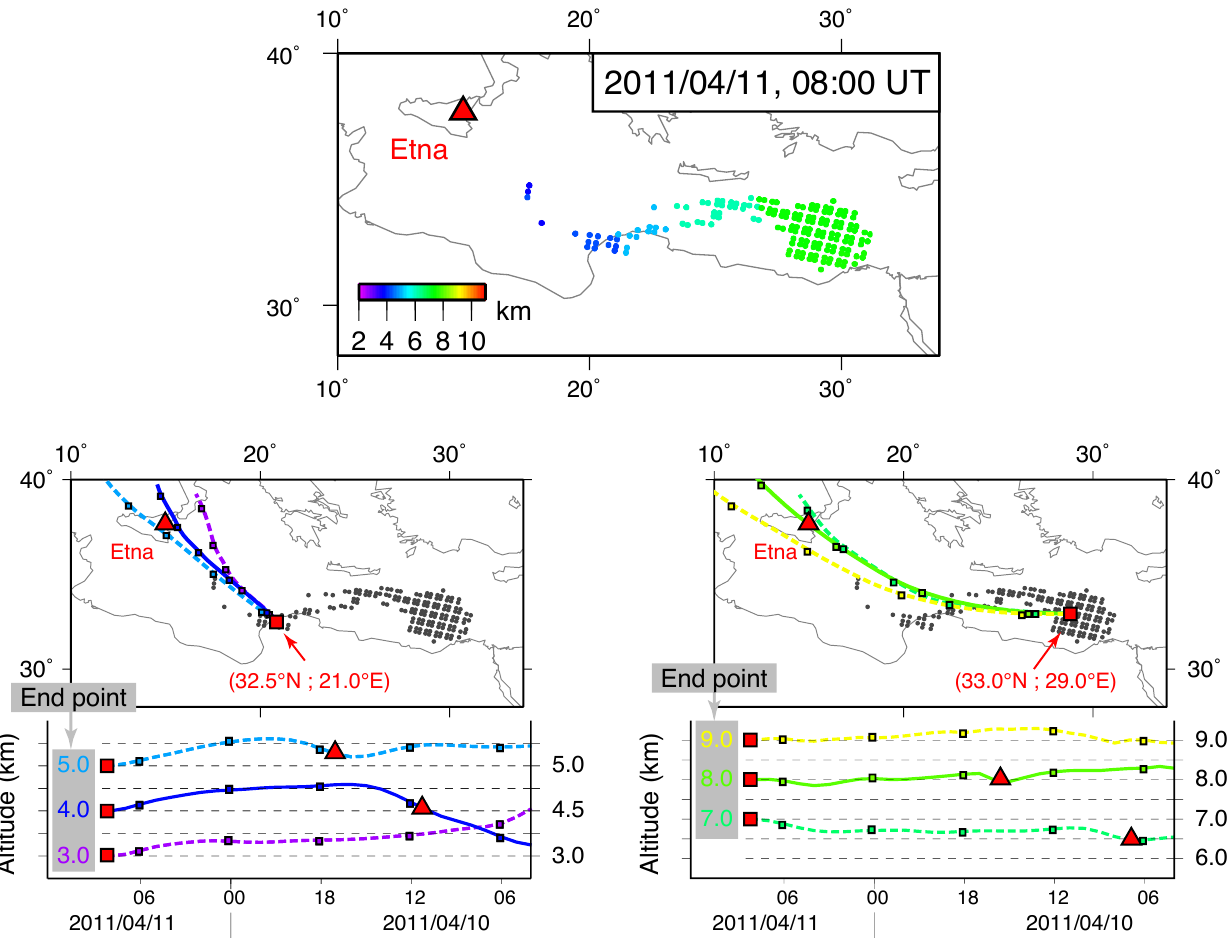
Figure 7. Comparison of the altitude (kma . s . l . ) of the dispersed Etna SO 2 cloud on 11 April 2011 08:00UT (top) simulated with the CHIMERE chemistry-transport model, initialized with emissions reconstructed by the inversion procedure and (bottom) deduced from HYS- PLIT backward trajectories starting from two opposite extremities of the SO 2 cloud either above Libya (32.5 ◦ N, 21.0 ◦ E; bottom left) or offshore Egypt (33.0 ◦ N, 29.0 ◦ E; bottom